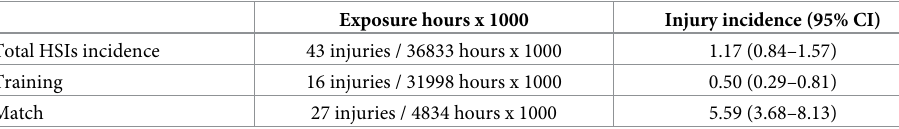
Table 2. Injury incidence per training and match time exposure